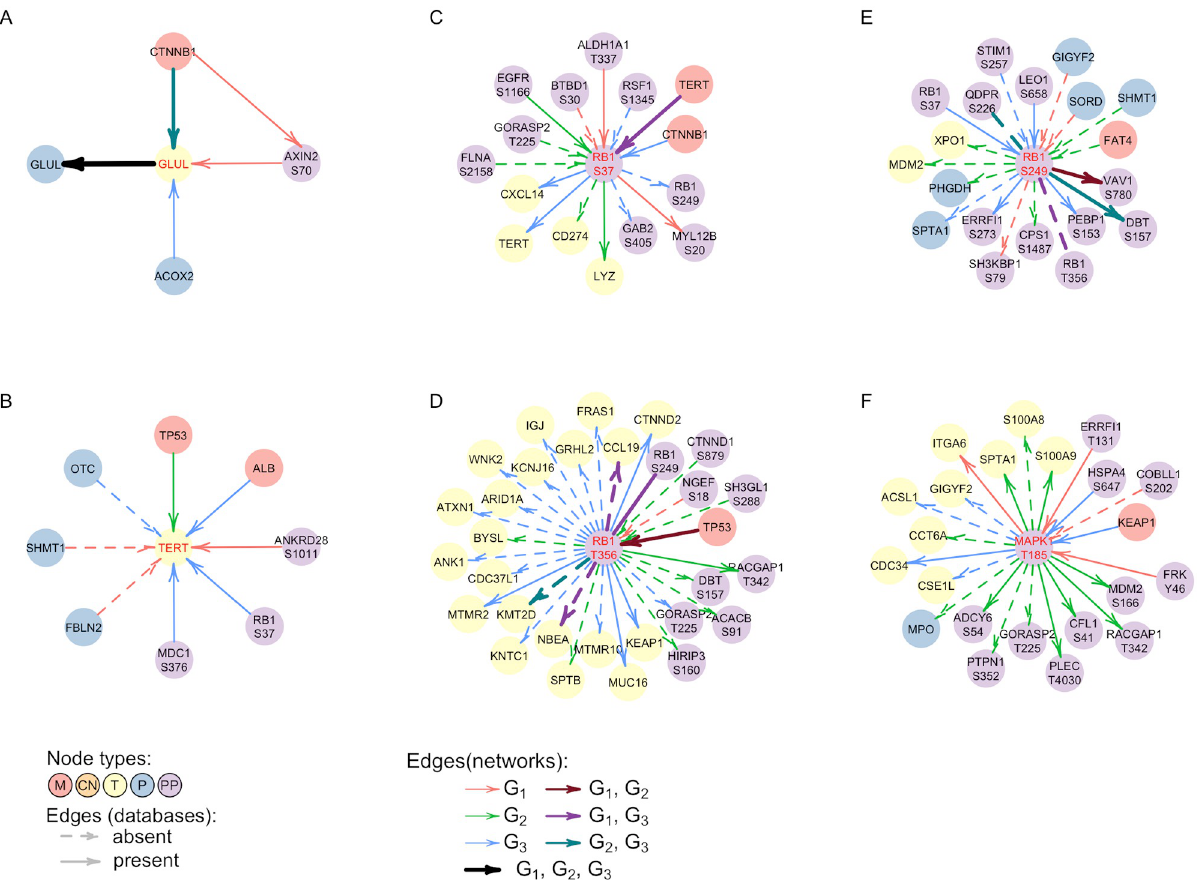
Fig 6. Neighborhoods of individual nodes in the networks learned by bnClustOmics. Direct neighbors of nodes (A) GLUL - T (B) TERT - T (C) RB1-S37 (D) RB1_T356 (E) RB1-S249 (F) MAPK1_T185 in multi-omics networks discovered by bnClustOmics. Interactions are only shown between the central node and all of its direct neighbors with exception of (A) where we also show the connection between CTNNB1 - M and